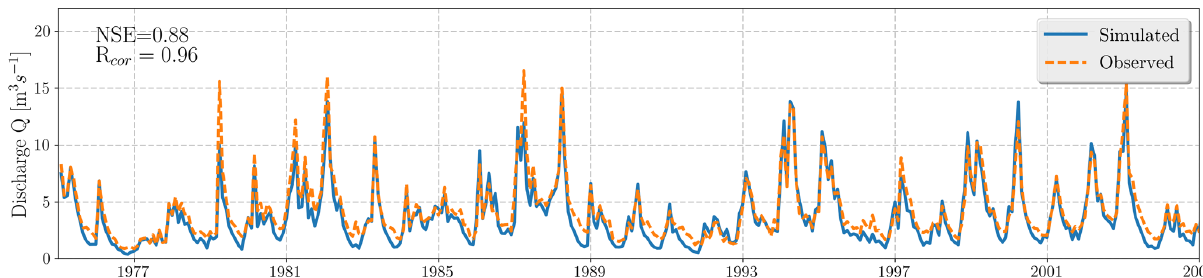
Figure 6. Observed and simulated monthly discharge at the outlet of the Nägelstedt catchment.